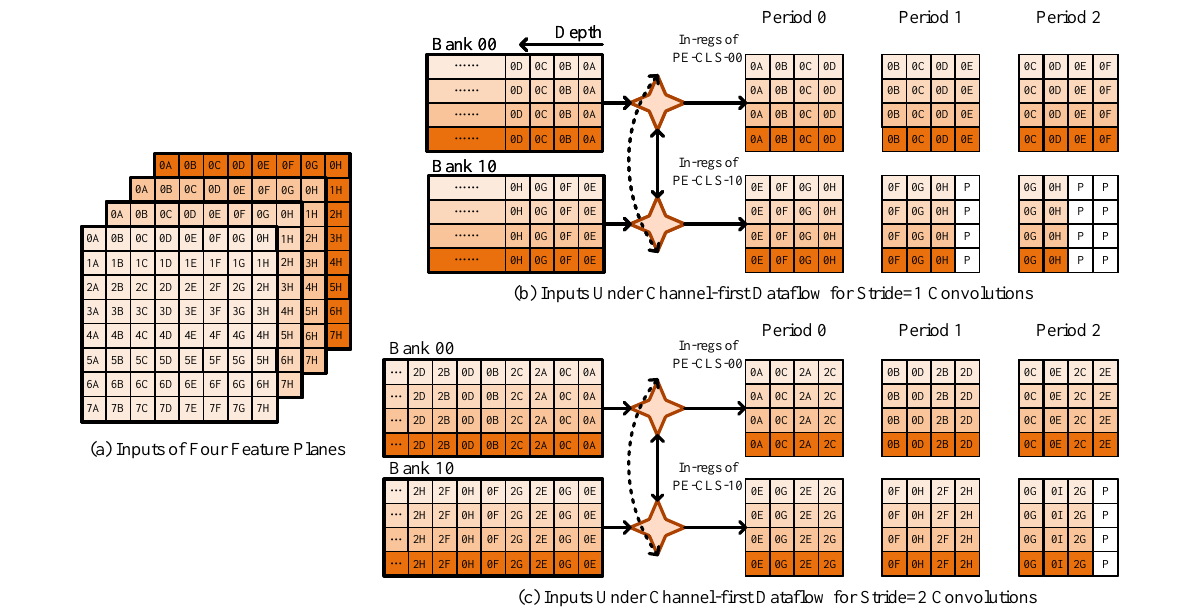
Figure 9. The data movement with stride = 1 and stride = 2 under the channel-first dataflow. P denotes the padding element.